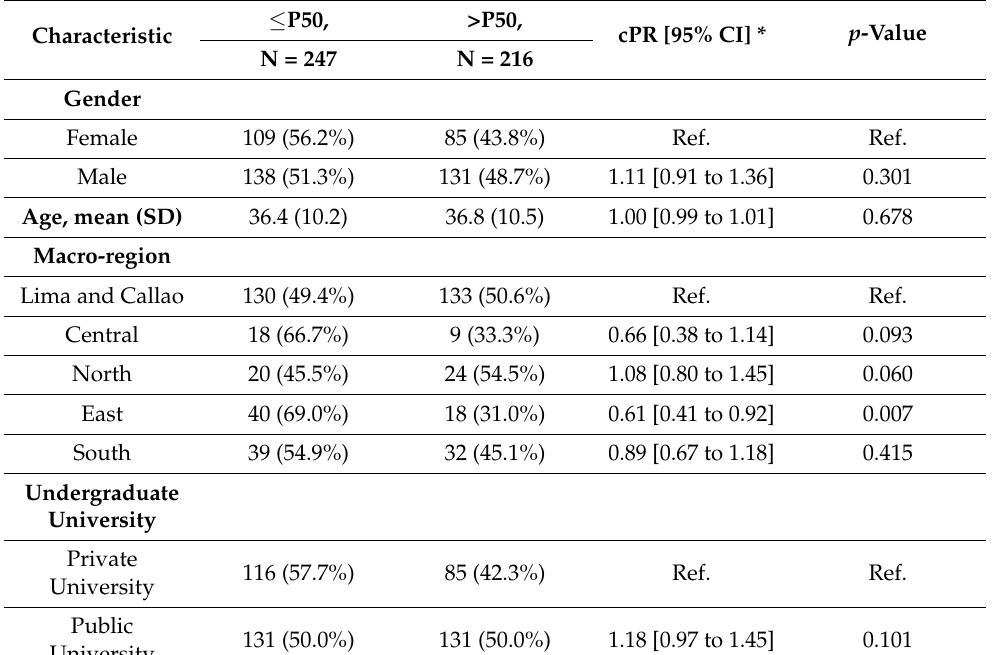
Table 3. Comparison of characteristics between those physicians with higher knowledge (>p50) and those with lower knowledge ( ≤ p50) of